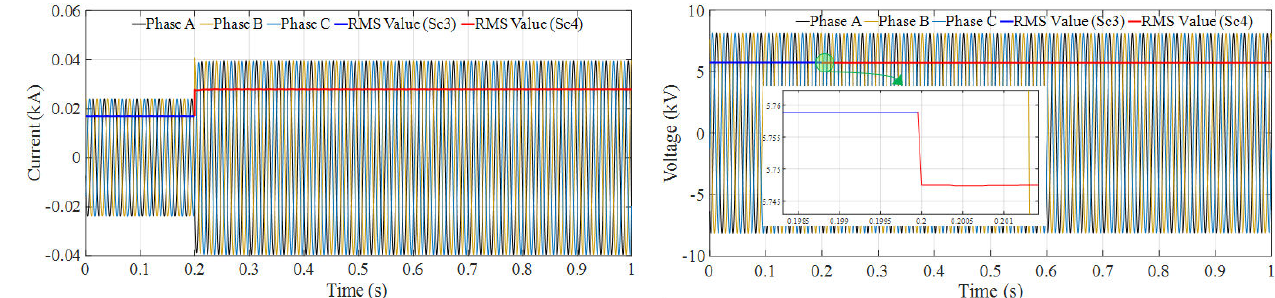
Figure 25. Voltage and current signals at the transformer secondary side for scenario 3 and scenario